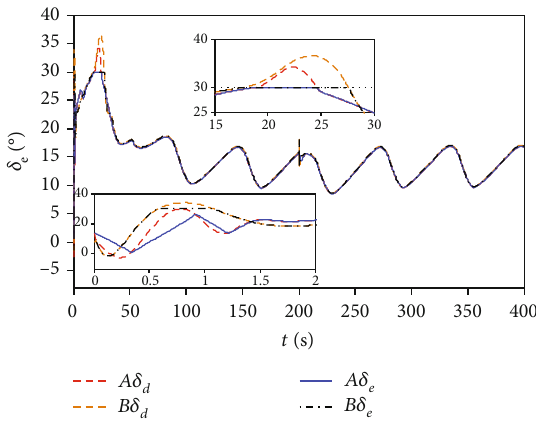
Figure 7: Tracking curves of AOA error.